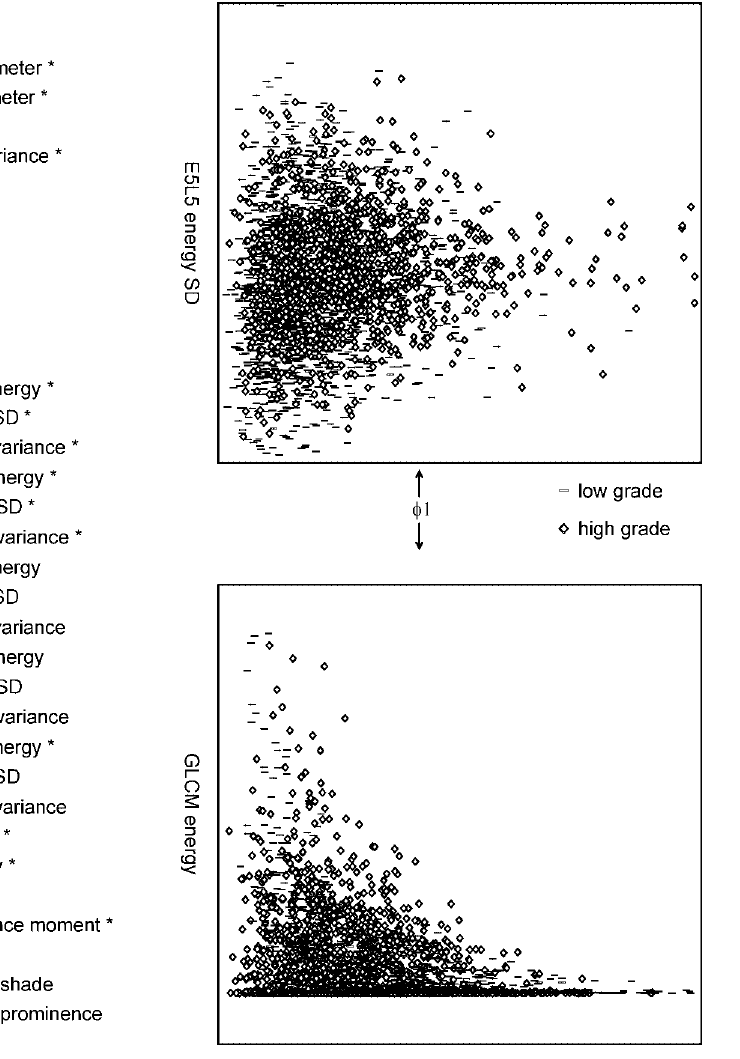
Fig. 1. Data profile of low and high grade (left). Central point is mean, and line mean + / − standard deviation; for clarity, variables are normalised. Note tendency of overlapping of values for low grade and high grade. Variables which means differs significantly between low grade and high grade (Mann–Whitney U test) are marked with ∗ . On the right two examples of overlapping of the features in 2D space is shown (group